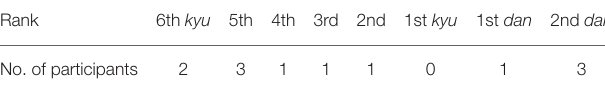
TABLE 1 | Formal expertise of participants in karate.